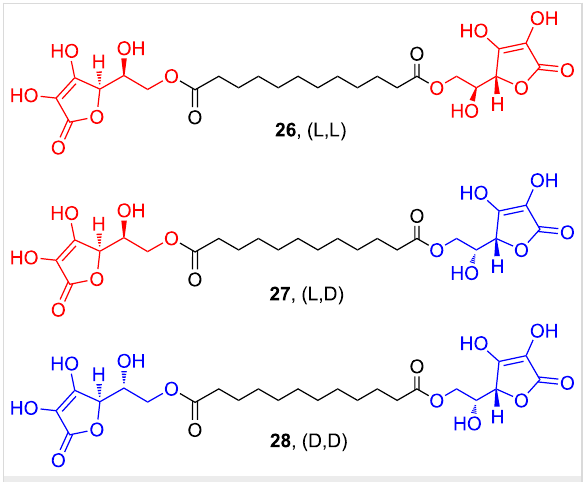
Figure 5: Bolaamphiphilic molecules containing (L)- and/or (D)- isoascorbic acid moieties.